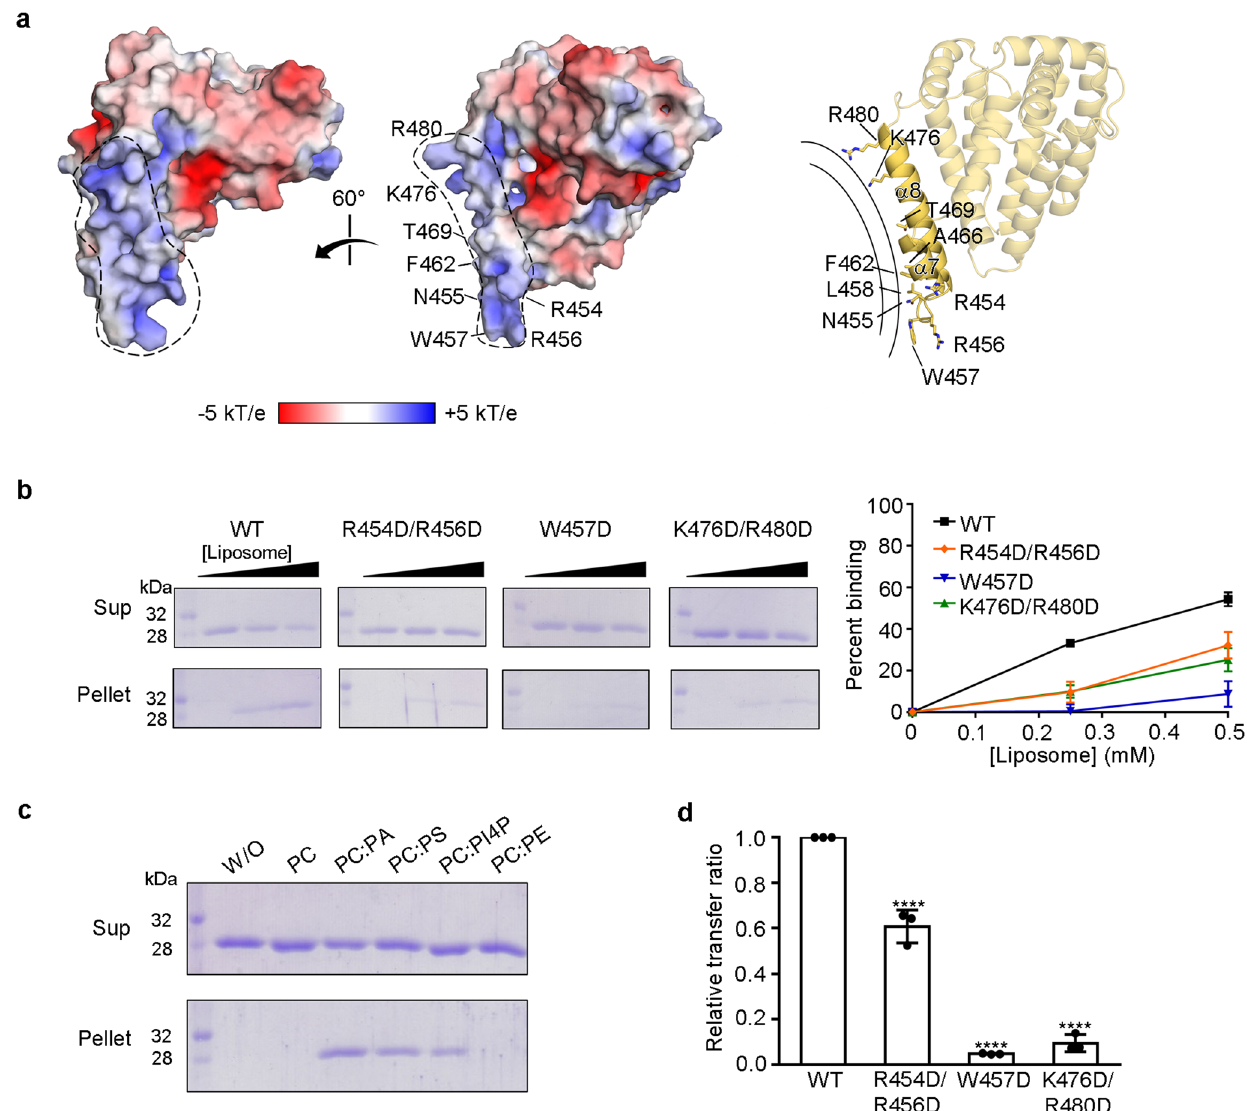
Fig. 6 zMiga2 docks with the membrane through a positively charged concave surface. a Molecular surface of the zMiga2, colored according to electrostatic potential. The two views are 60° rotation around a vertical axis. The electrostatic potential was calculated with the APBS program 57 and colored from − 5 (red) to + 5 (blue) kT/e (k, Boltzmann ’ s constant; T, temperature; e, charge of an electron). The membrane-associated region of zMiga2 is highlighted by dashed lines. A ribbon diagram on the right panel (in the same orientation as the middle panel) shows key residues involved in the association with the membrane. b Liposome sedimentation assay showing the direct membrane association of zMiga2. The experiments using wild type and mutants (R454D/ R456D, W457D, and K476D/R480D) of zMiga2 were performed as shown in Fig. 1c. The right panel shows the quanti fi cation data using left ( N = 3 independent experiments; dot shows mean±SD). c Liposome sedimentation assay using a series of liposomes (PC, PC:PA, PC:PS, PC:PI4P, and PC:PE) ( N = 2 independent experiments). d A graph comparing the transfer ratio between zMiga2 WT and each mutant (R454D/R456D, W457D, and K476D/R480D). Lipid transfer activity was compared with that of WT using one-way ANOVA ( N = 3 independent experiments; individual data point shown as dots, bars show